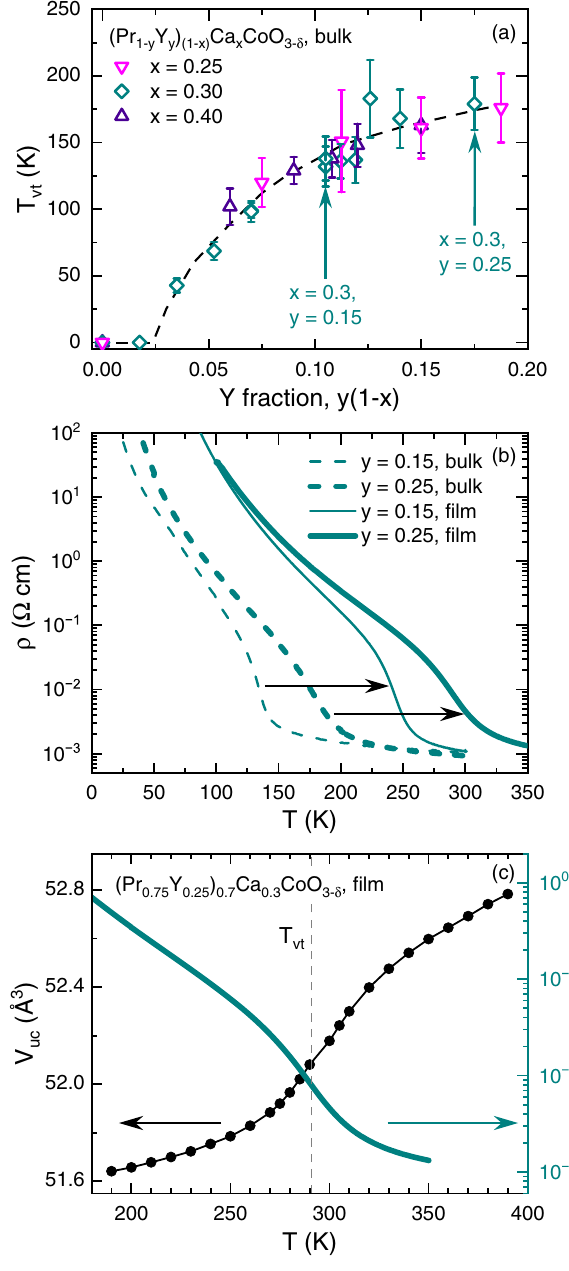
Fig. 7 | Room-Temperature T vt in compressively-strained (Pr 0.75 Y 0.25 ) 0.7 Ca 0.3 CoO 3- δ . ( a ) T vt vs. Y substitution fraction ( y (1- x )) for bulk poly- crystalline (Pr 1- y Y y ) 1- x Ca x CoO 3- δ with x =0.25, 0.30, and 0.40. The x =0.30, y =0.15 and x =0.30, y =0.25 compositions are highlighted, i.e., the standard composition in this work, and the highest- T vt composition, respectively. Error bars correspond to the approximate width of the transition from the widths of the peaks in Zab- rodskii plots (see Figs. S4, S10), and the dashed line is a guide to the eye. ( b ) Temperature( T )dependenceoftheresistivity( ρ )(log 10 scale,takenonwarming)of x =0.30samplesat y =0.15and0.25,forbothbulkpolycrystals(dashed)and30-40- unit-cell-thick fi lms on YAO(101)substrates(solid).Horizontalarrowshighlight the strain enhancement of the transition temperature, which reaches 291K at y =0.25 (see Fig. S10). ( c ) T -dependenceof the pseudocubic unitcellvolume ( V uc , left axis) and resistivity ( ρ , right axis) of a 41-unit-cell-thick (Pr 0.75 Y 0.25 ) 0.7 Ca 0.3 CoO 3- δ fi lm on YAO(101). The vertical dashed line marks the valence transition temperature T vt =291K, as determined from the peak in a Zabrodskii plot 60 , as shown in Fig.